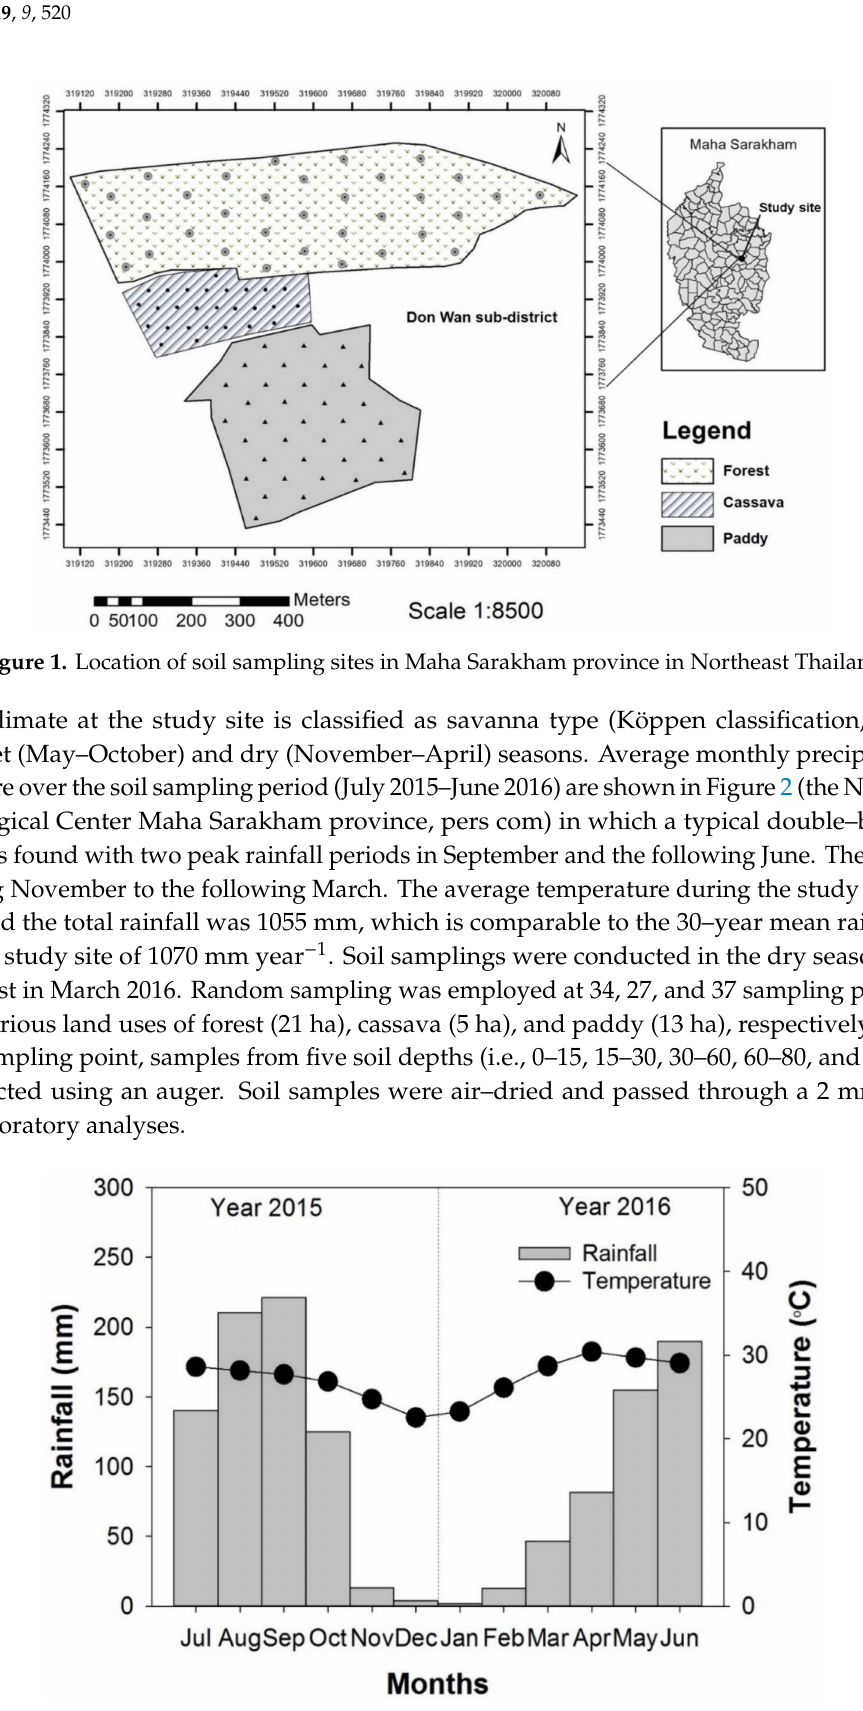
Figure 2. Average rainfall (mm) and temperature ( ◦ C) of the study site during July 2015–June